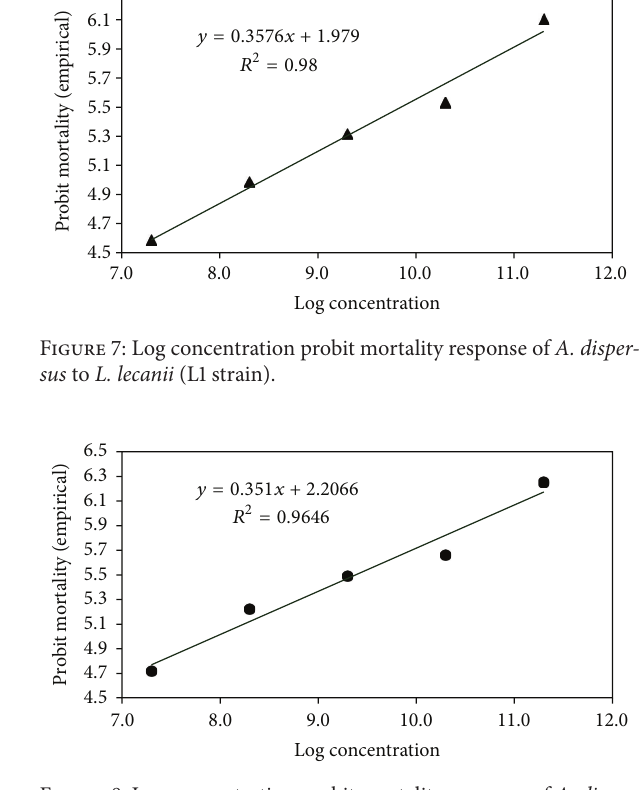
Figure 8: Log concentration probit mortality response of A. disper- sus to P. fumosoroseus (P1